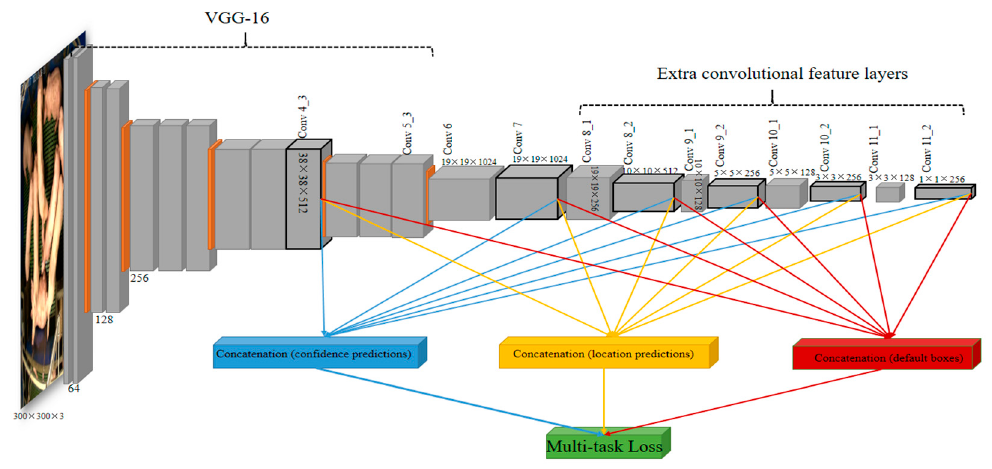
Figure 3. The architecture of SSD object detection.